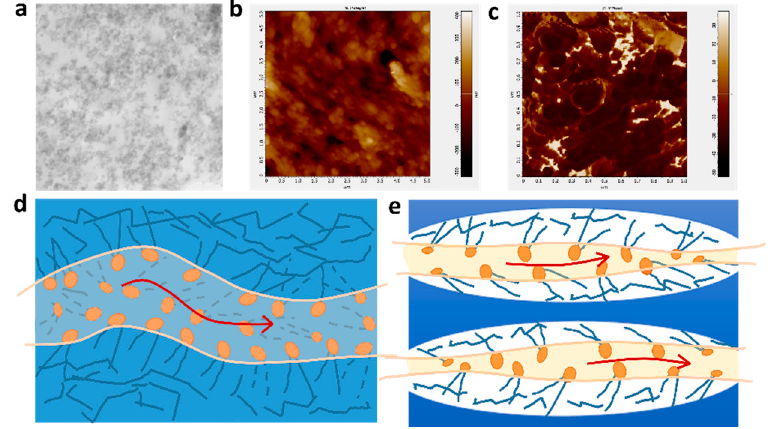
Figure 5. ( a ) Surface TEM images, ( b ) AFM topography images, ( c ) AFM phase images of D ‐ DMAc ‐